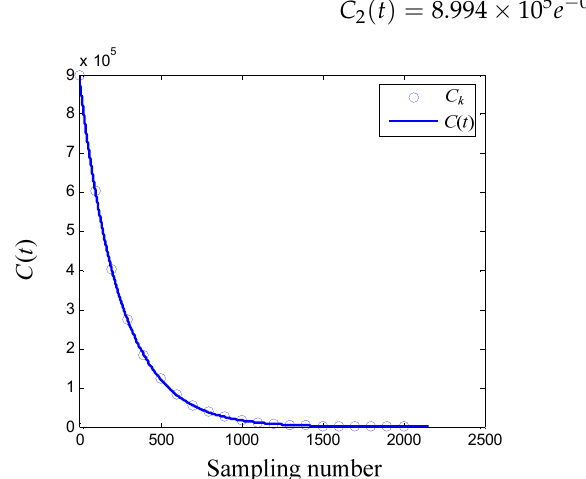
Figure 10. The initial hazard function